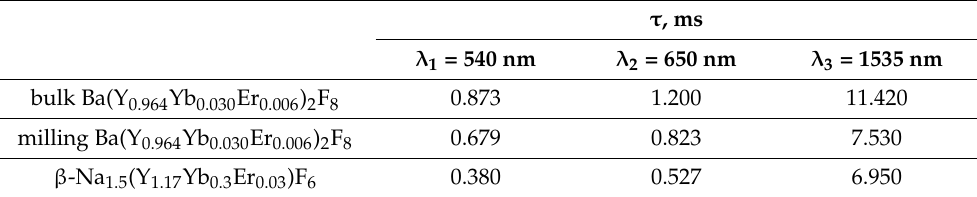
Table 2. The PL lifetimes of Er 3+ excited states in specified